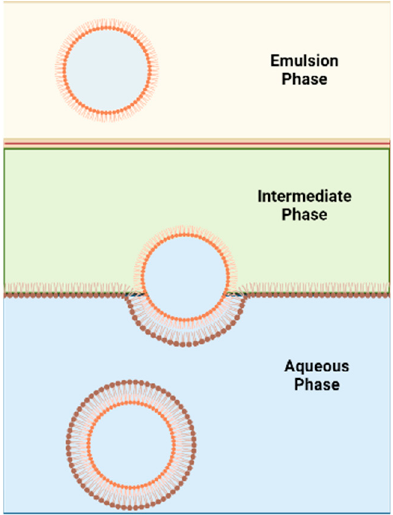
Figure 7. Schematic diagram of the inverse emulsion method.